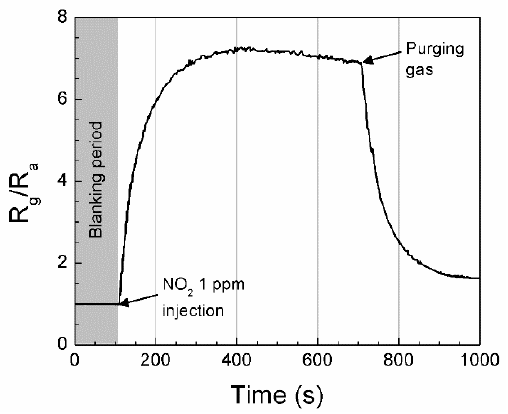
Figure 4. Response curve of the IN (In 2 O 3 ) sensor for real-time motoring of NO 2 . The gas sensing process is composed of three steps, i.e., blanking period for 100 s, exposure to target gas for 600 s, and finally regeneration by dry air purging.